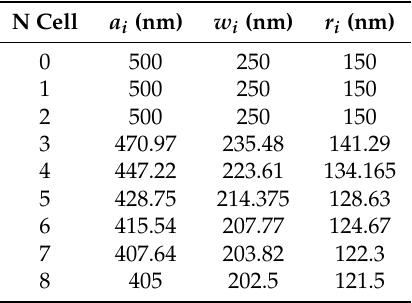
Figure 1. ( a ) Geometry of the simulated uniform optical structure. Geometric parameters D (waveguide–cavity distance) and L 0 (mirror position) are shown. ( b ) Unit cell and geometric parameters of the unit cell in the perfect phoxonic crystal. Table 1. Uniform cavity